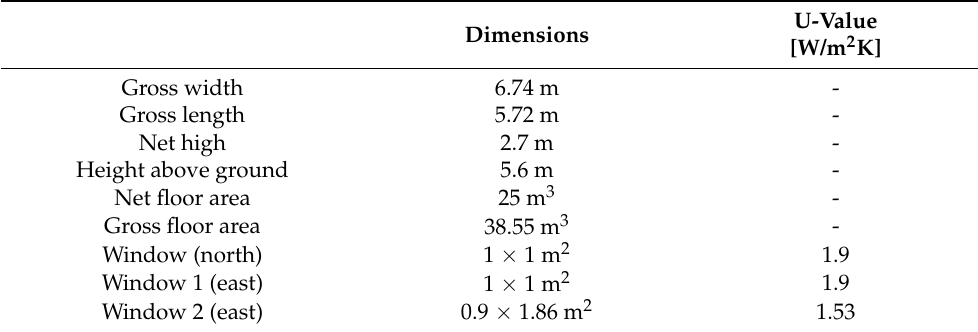
Table 3. Geometrical data and window